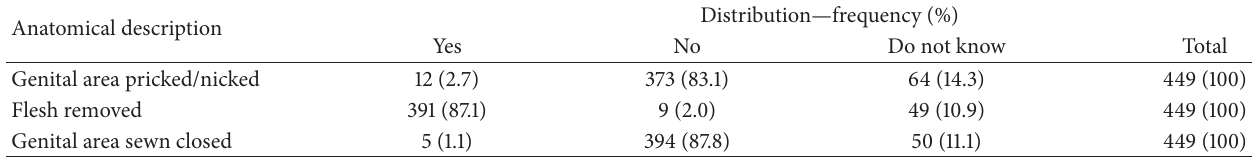
Table 6: Self-reported anatomical description (using DHS